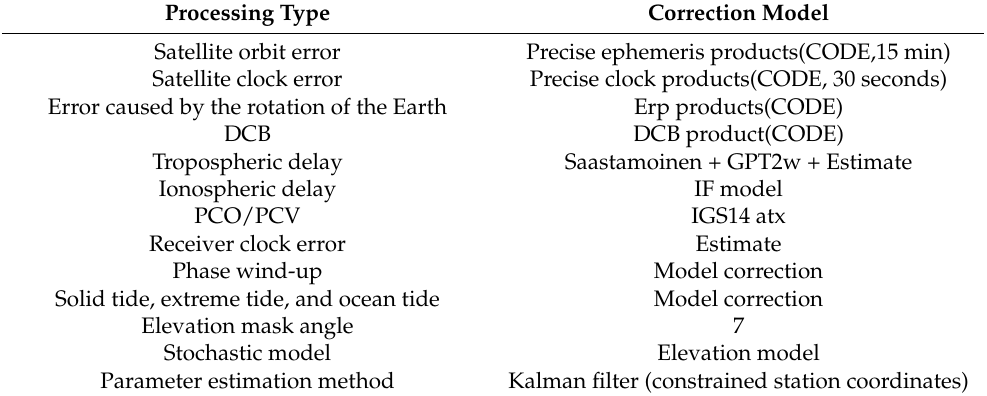
Table 1. PPP data processing model.